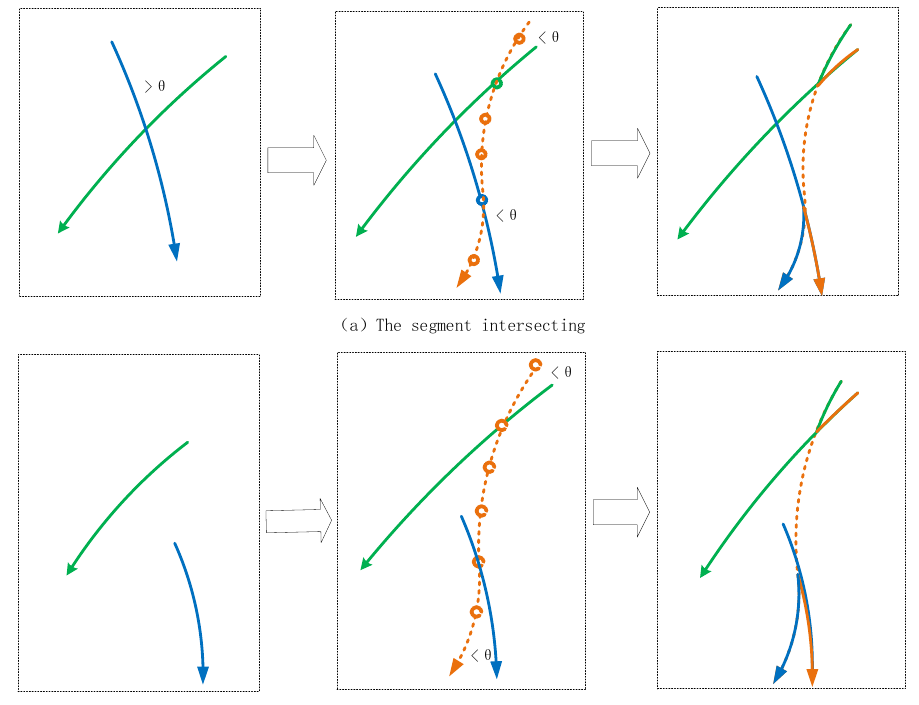
Figure 2. The process to pair the remaining trajectory segments.